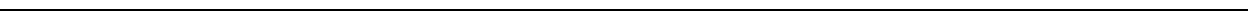
Fig. 6 Schematic summary and sensor performance for GCaMP and GCaMP-X. a GCaMP defects and advantages of GCaMP-X. In neurons, GCaMP sensors behave as CaM-like proteins perturbing Ca V 1 gating and distorting Ca 2 + dynamics (1). The abnormal enhancement of Ca V 1 by cytosolic GCaMP underlies overgrown neurites. Different from endogenous CaM, GCaMP itself could no longer properly translocate into the nucleus in response to membrane excitation, which also dominant-negatively impairs the acute mobility of endogenous CaM. Once present in the nucleus (by accumulation or NLS), nuclear GCaMP perturbs transcription signaling and gene expression potentially through its aberrant CaM motif, impairing general health of neurons including Ca 2 + signals (re fl ected as abnormal sensor readouts) and neurite outgrowth (2). The new GCaMP-X sensors are designed with apoCaM protection and explicit localization (e.g., GCaMP-X C for cytosolic Ca 2 + ) to eliminate GCaMP perturbations on Ca V 1 gating (3) and signaling (4). b Sensor performance of GCaMP-X C validated by single-AP like Ca 2 + transients in HEK293 cells. Brie fl y, glass electrodes formed the Giga-Ohm seal with cell membrane (resting); then 3 ms ZAP for break-in generated a rapid Ca 2 + in fl ux due to transient membrane rupture, immediately followed by a fast decay arising from strong Ca 2 + chelators of 10 mM BAPTA included in the pipette solution. Key indices of peak Δ F/F 0 , rise time t r , decay time t d and SNR were compared between GCaMP6m and GCaMP6m-X C . Epi- fl uorescence images were acquired at the sampling rate of 100 Hz or higher. c – e Sensor performance of GCaMP-X C validated with mechanosensing outer hair cells. Cells were transfected with GCaMP6m or GCaMP6m-X C at P1 by electroporation, and cultured for 1 day (DIV 1) or 3 days (DIV 3). Fluid-jet pulses of 100, 300 or 500 ms were applied to cells ( c ). Representative images, normalized fl uorescence changes ( Δ F/F 0 ) indicative of Ca 2 + dynamics and statistical summary of peak Δ F/F 0 were compared between DIV 1 ( d ) and DIV 3 ( e ) cells expressing GCaMP6m or GCaM6m-X C . Standard error of the mean (S.E.M.) and Student ’ s t -test (two-tailed unpaired with criteria of signi fi cance: * p < 0.05; ** p < 0.01, and *** p < 0.001) were calculated when applicable, and n.s. denotes “ not signi fi cant